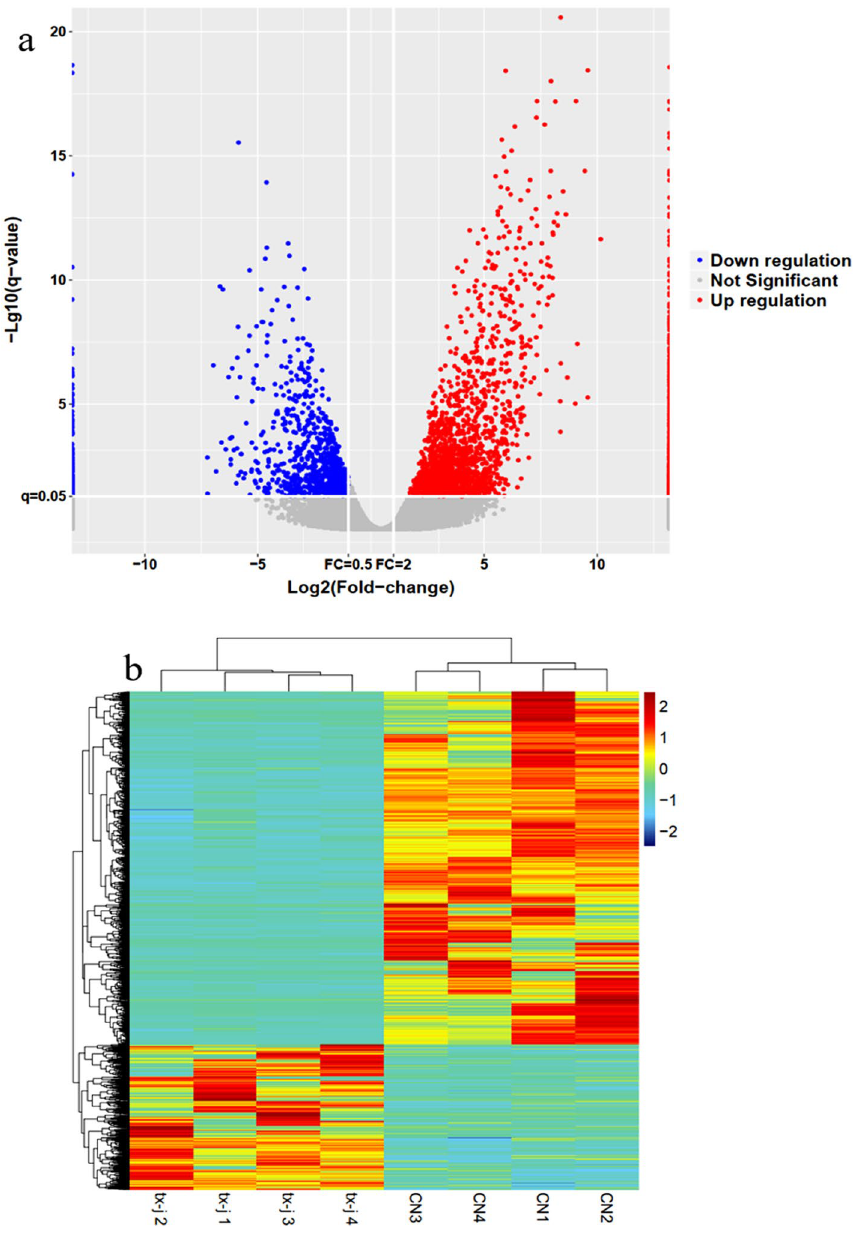
Figure 3. ( a , b ) Display the lncRNAs’ expression by use of volcano plots and heatmap. Supervised hierarchical cluster analysis shows that the different mRNA can correctly distinguish the model group from the control